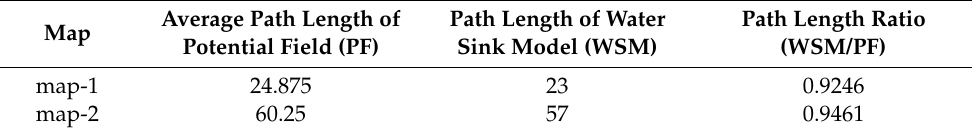
Table 5. Comparison of water sink model with potential field method. Averaged path length of potential field, if successful, deterministic path length of water sink model and path length ratio. The unit is